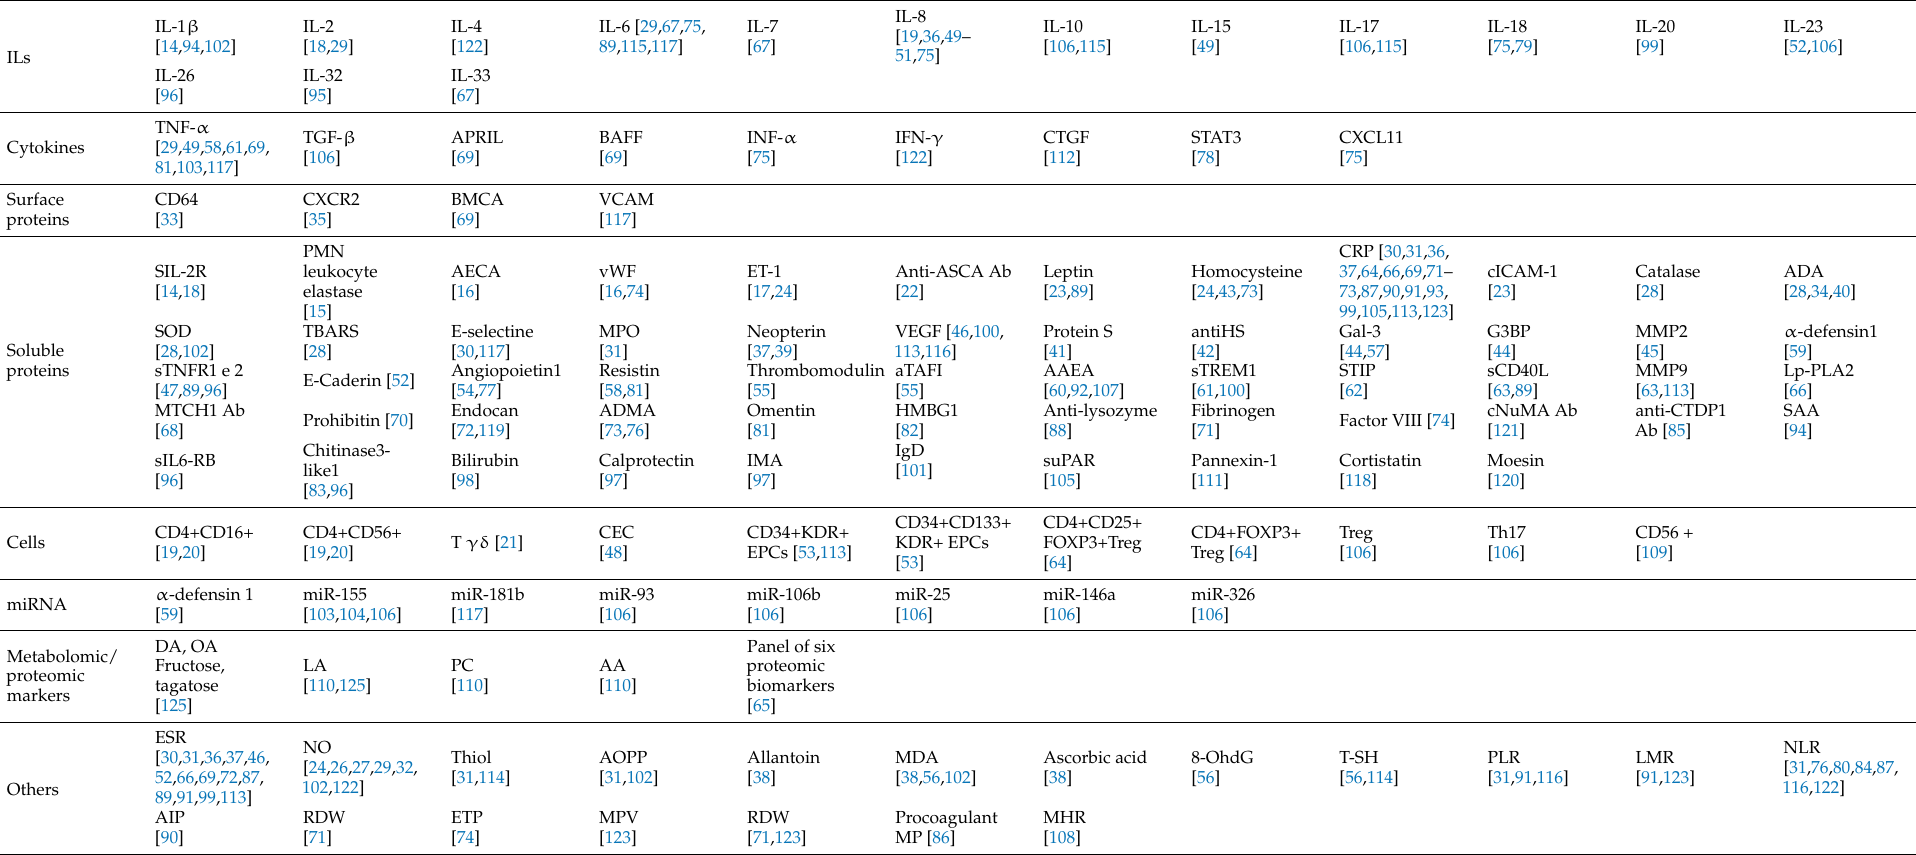
Table 2. Serological and urinary biomarkers investigated in the studies included in the systematic